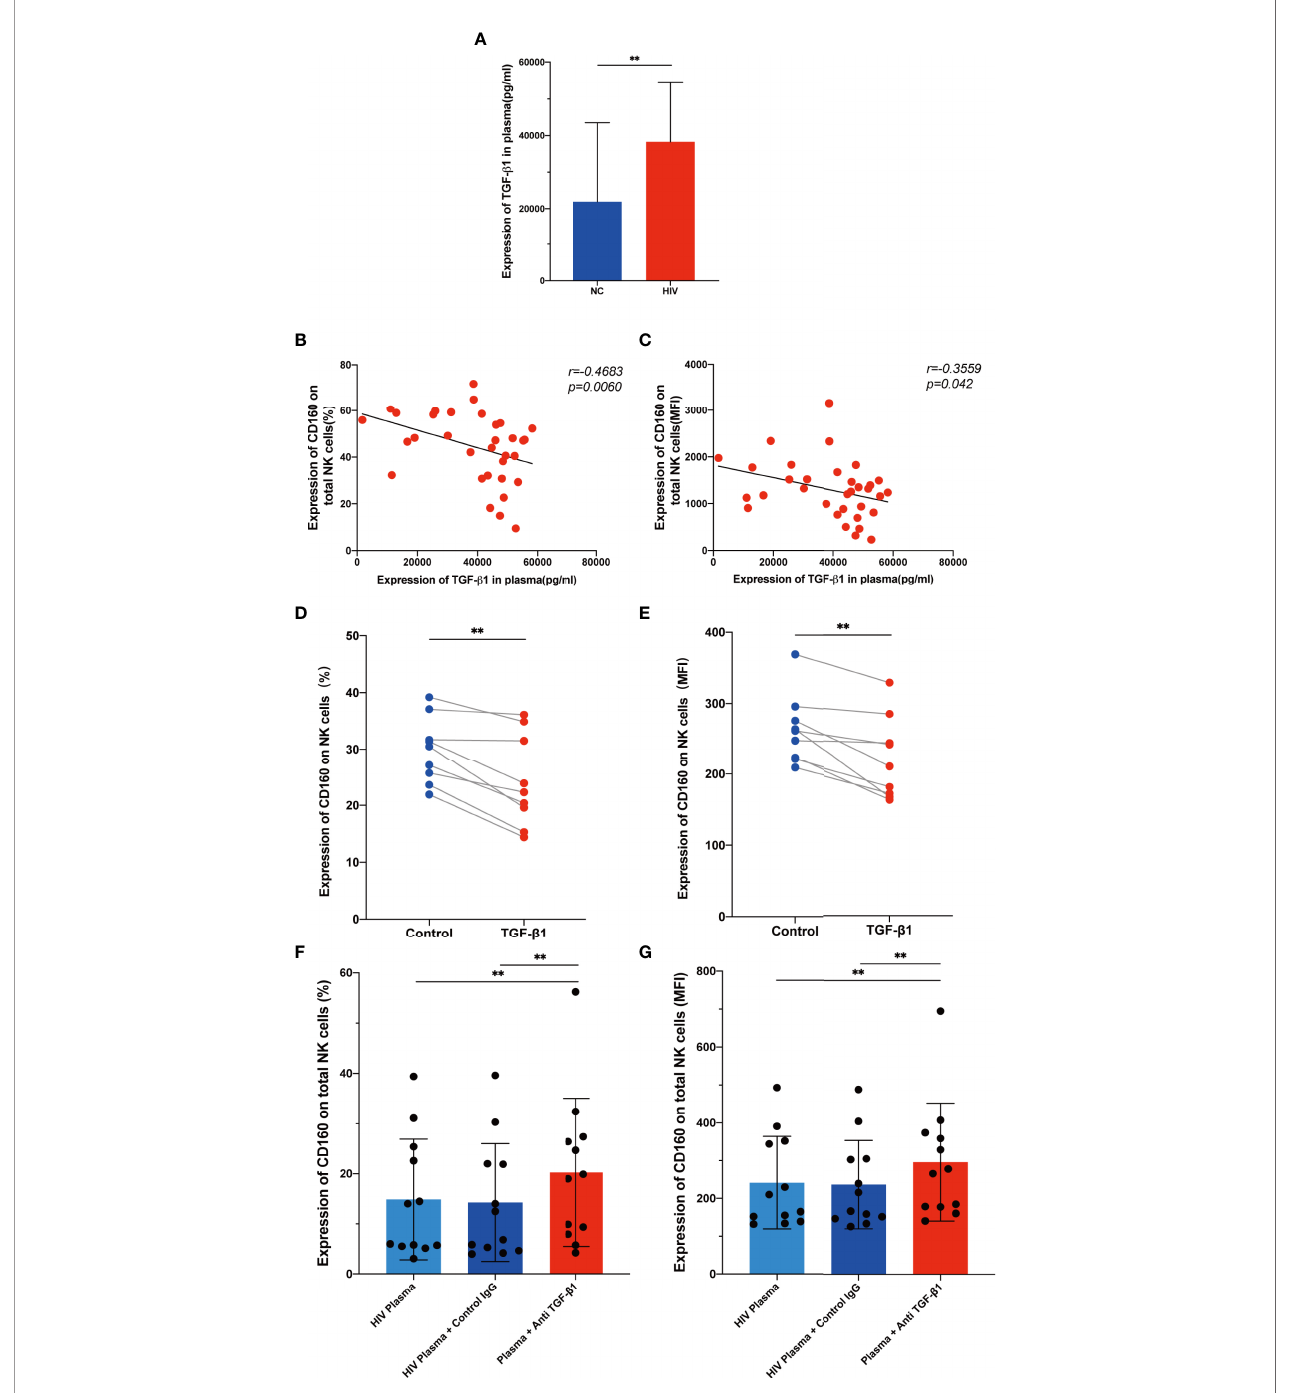
FIGURE 6 | TGF- b inhibits CD160 expression on NK cells. (A) Levels of TGF- b 1 in plasma from HIV-infected individuals (n = 39) and HIV-negative controls (n = 21). (B, C) Correlations between levels of TGF- b 1 and the percentages (B) or MFI (C) of CD160 on total NK cells from HIV-infected individuals (n = 33). (D, E) Cultured with medium alone, or with TGF- b 1 (10 ng/ml). Percentages (D) , and MFI (E) of CD160 on total NK cells from HIV-infected individuals were analyzed by fl ow cytometry (n=9). (F, G) PBMCs cultured with HIV-infected individual plasma alone (left), cultured with HIV-infected individual plasma and control IgG (middle), or cultured with HIV-infected individual plasma and anti-human TGF- b 1-neutralizing antibody (right), were analyzed by fl ow cytometry to detect the percentage (F) and MFI (G) of CD160 on total NK cells from HIV-infected individuals (n = 12). The mean fl uorescence intensity of CD160 in (C, E, G) was from total NK cells. A Wilcoxon matched-pairs signed-rank test was employed for paired-group comparisons. A Spearman ’ s rank test was used for correlation analysis; ** P < 0.01. Data are represented as means ±